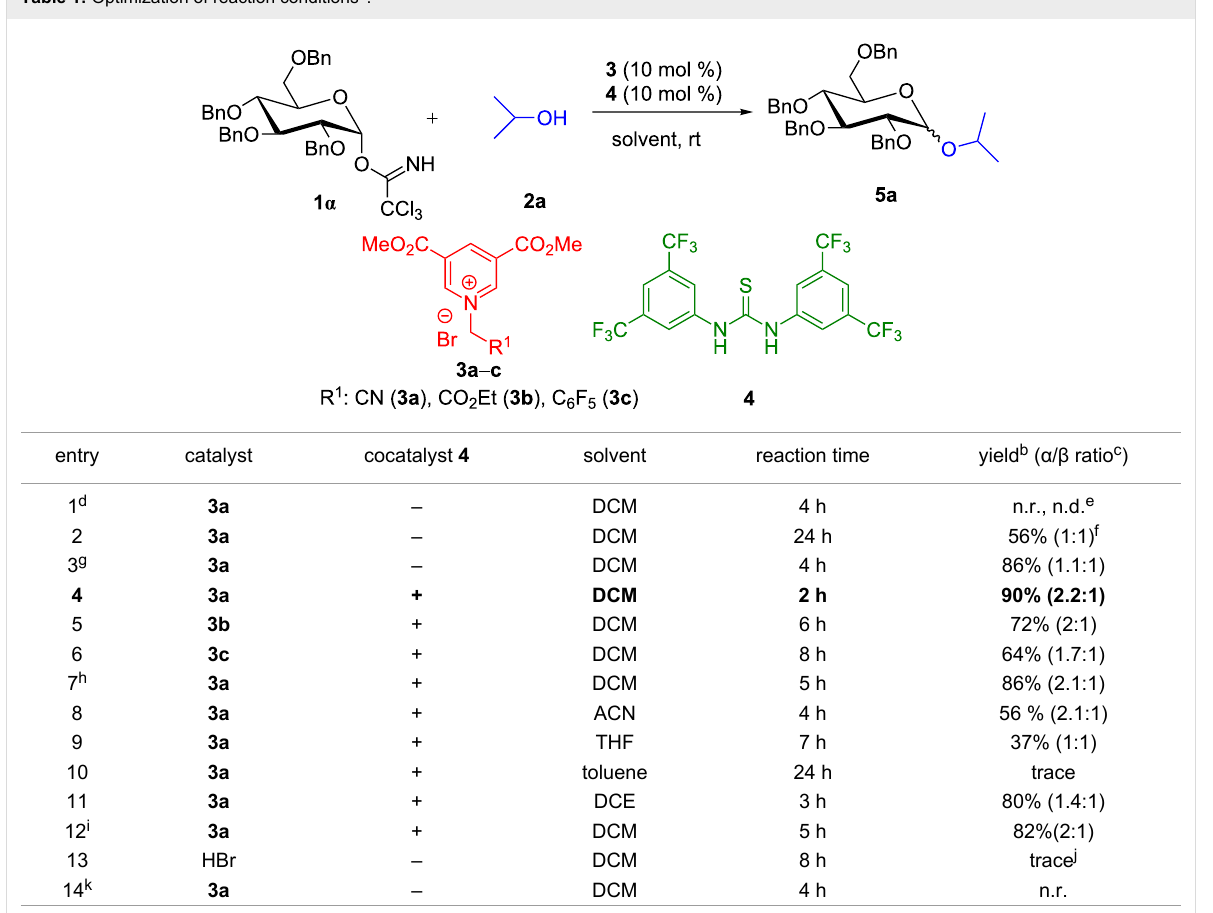
Table 1: Optimization of reaction conditions a